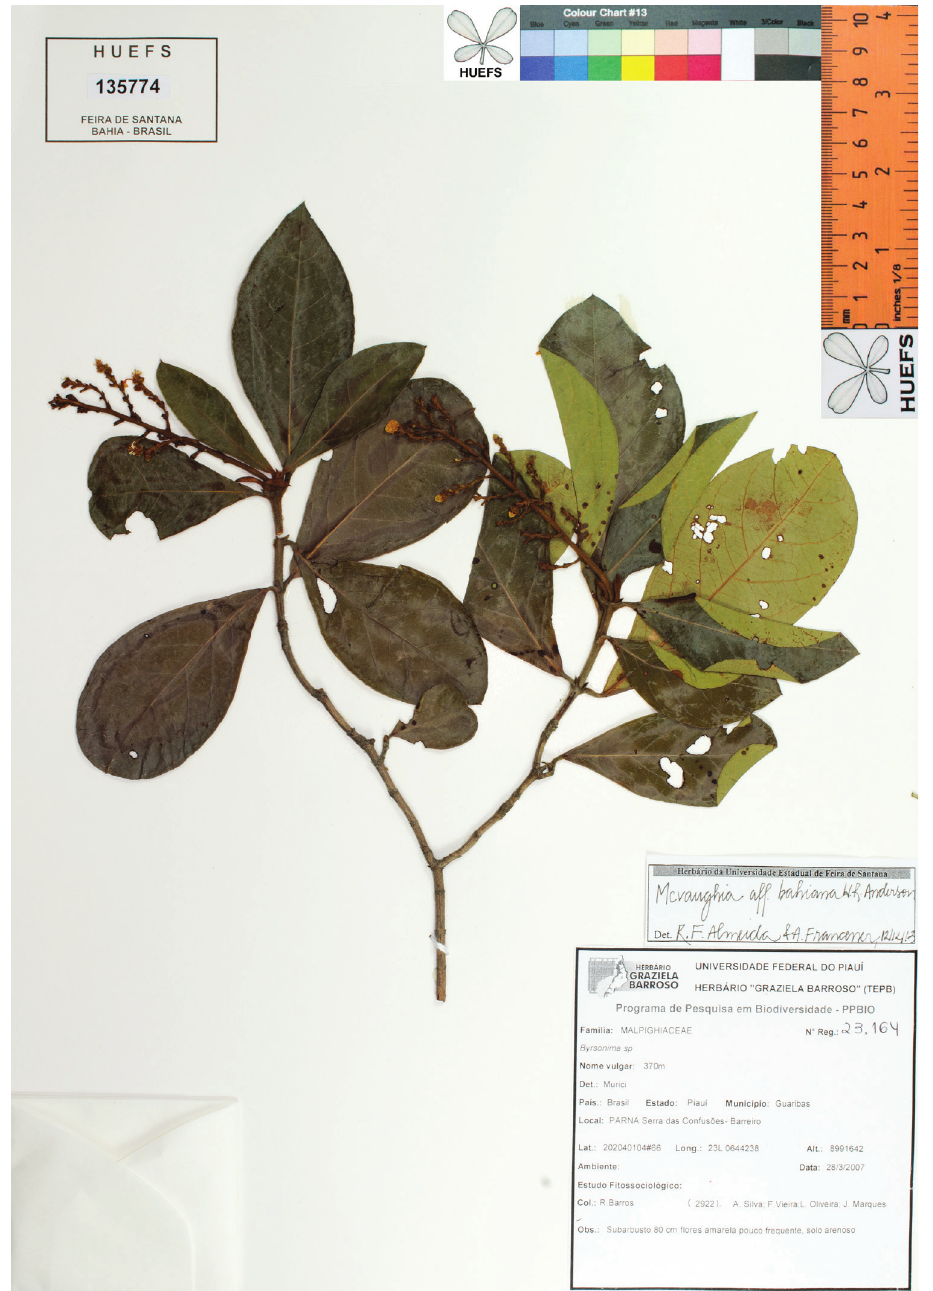
Figure 8. Photograph of the holotype of Mcvaughia piauhiensis